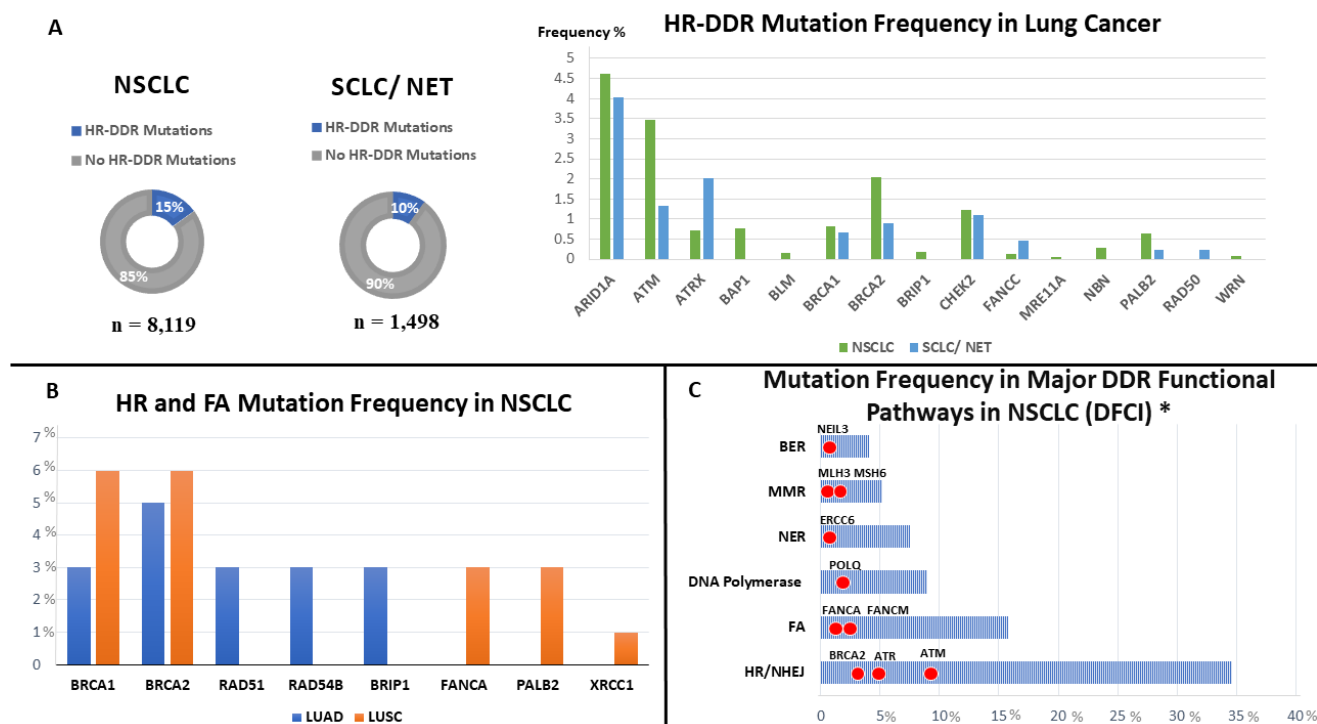
Figure 2. Reported frequencies of DDR alterations in NSCLC and SCLC. ( A ) Frequency of HR-DDR mutations from Caris cohort in NSCLC and SCLC represented in pie charts and, to the right of the panel, the reported frequencies of most common mutated HR-DDR genes in NSCLC (green) and SCLC (blue). ( B ) Selected reported frequencies in lung adenocarcinoma (LUAD) ( n = 230) and lung squamous cell carcinoma (LUSC) ( n = 178) from the TCGA database in NSCLC. ( C ) Mutation frequency in major DDR functional pathways in NSCLC from the Dana-Farber Cancer Institute cohort ( n = 266), with blue bar charts representing frequency of the major DDR pathway mutations, and red dots representing specific highly mutated genes within the major DDR pathway. *: This cohort include metastatic non-small cell lung cancer patients treated with PD-(L)1 inhibitors.